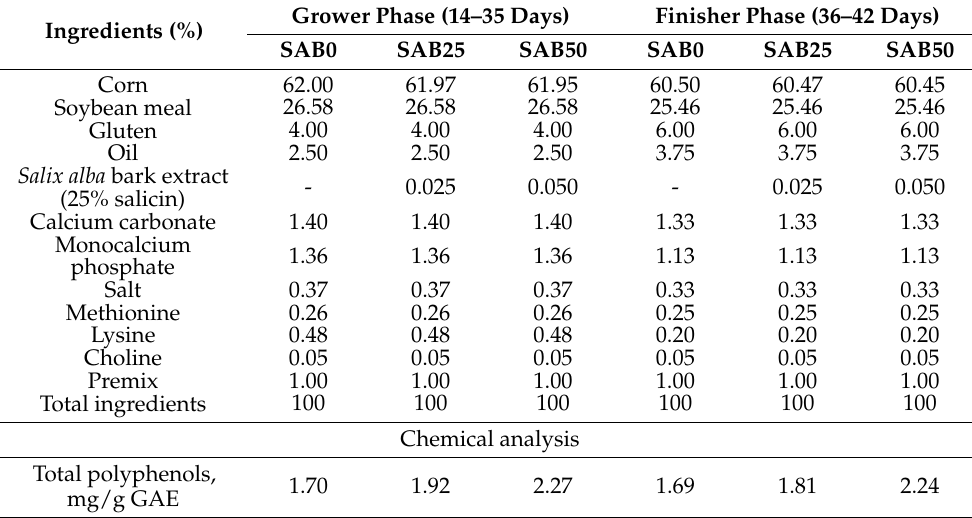
Table 1. Diet structure of experimental diets